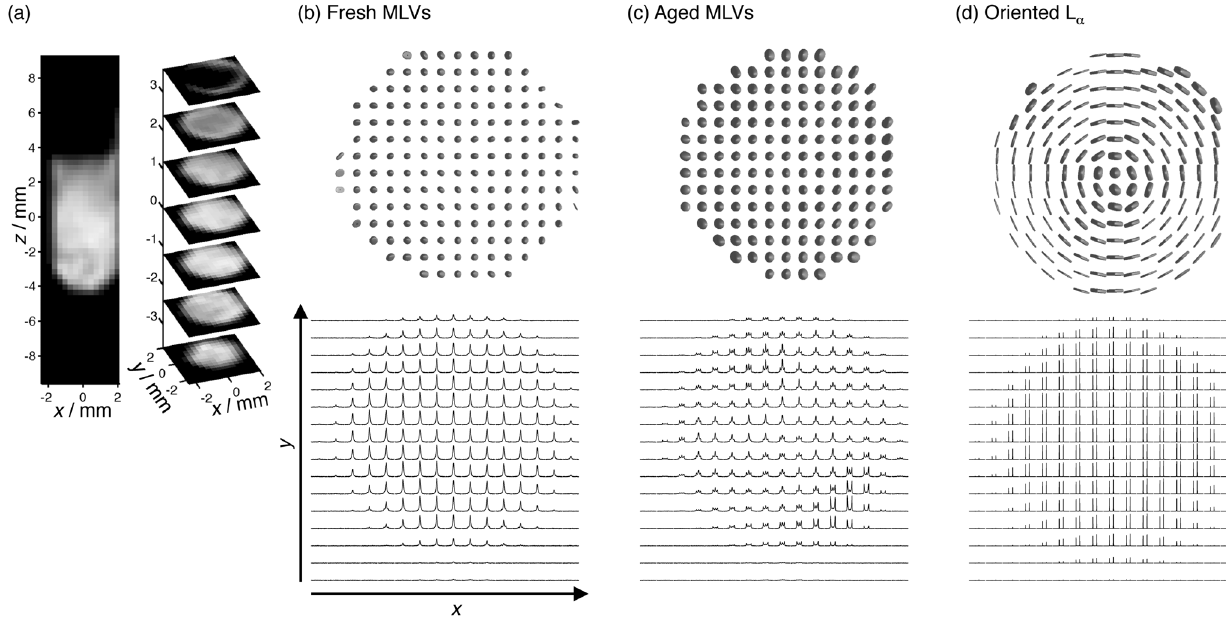
Figure 3. Representative DTI and 2 H data for C 10 E 3 /water lamellar phases. (a) Selected 2D slices from a conventional T 2 -weighted 1 H 3D image for a freshly prepared sample of multi-lamellar vesicles (MLVs). (b), (c), and (d): 2D arrays of diffusion tensors (top) and 2 H spectra (bottom) for fresh MLVs, 12 days aged MLVs, and an oriented lamellar phase L a obtained by 36 days equilibration after a temperature quench. The 2D arrays show the z ~ 0 slices extracted from the full data sets with spatial resolution in three dimensions. Diffusion tensors are shown only for voxels with 1 H signal intensity significantly above the noise level.